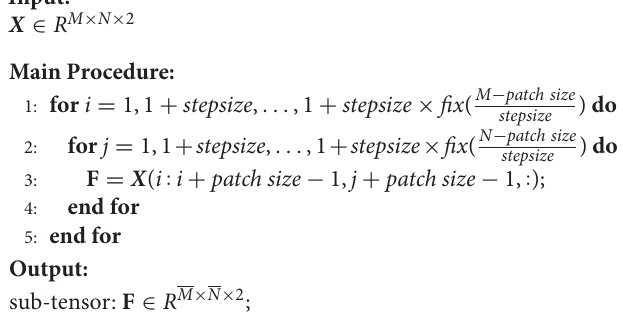
Algorithm 2: The Sub-tensor obtained by Sliding Window Technology